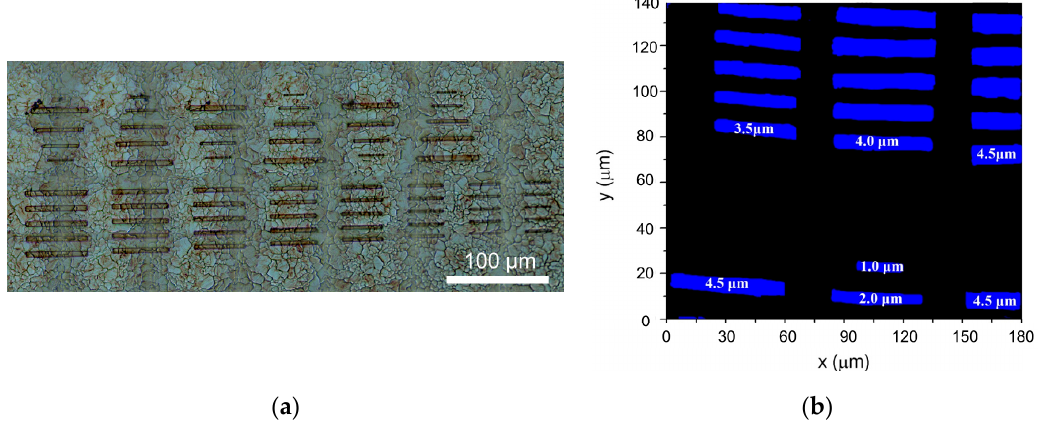
Figure 2. ( a ) Optical image of produced graphene micro ribbons on copper–silicon wafer after Lithography and Plasma etching process. The micro–ribbons are still covered by the AZ 726MIF photoresist, and ( b ) Raman mapping on graphene–copper–silicon wafer after dissolving AZ 726MIF photoresist. The blue color corresponds to the intensity of 2D peak.